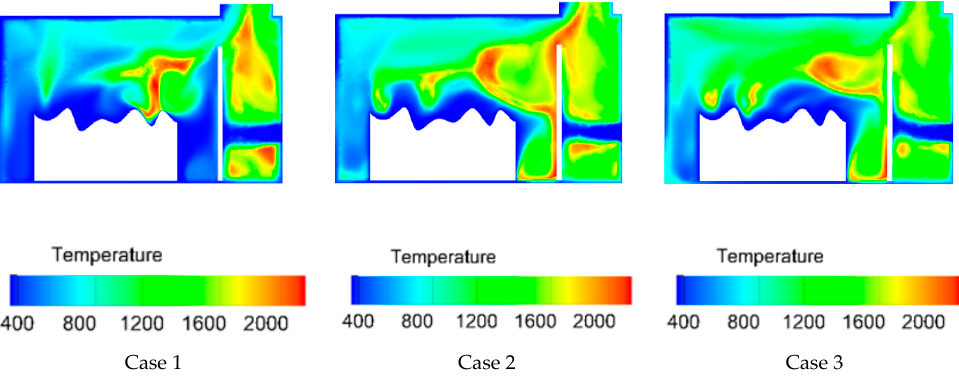
Figure 11. Temperature contours inside the primary and secondary chambers of the incinerator (K).